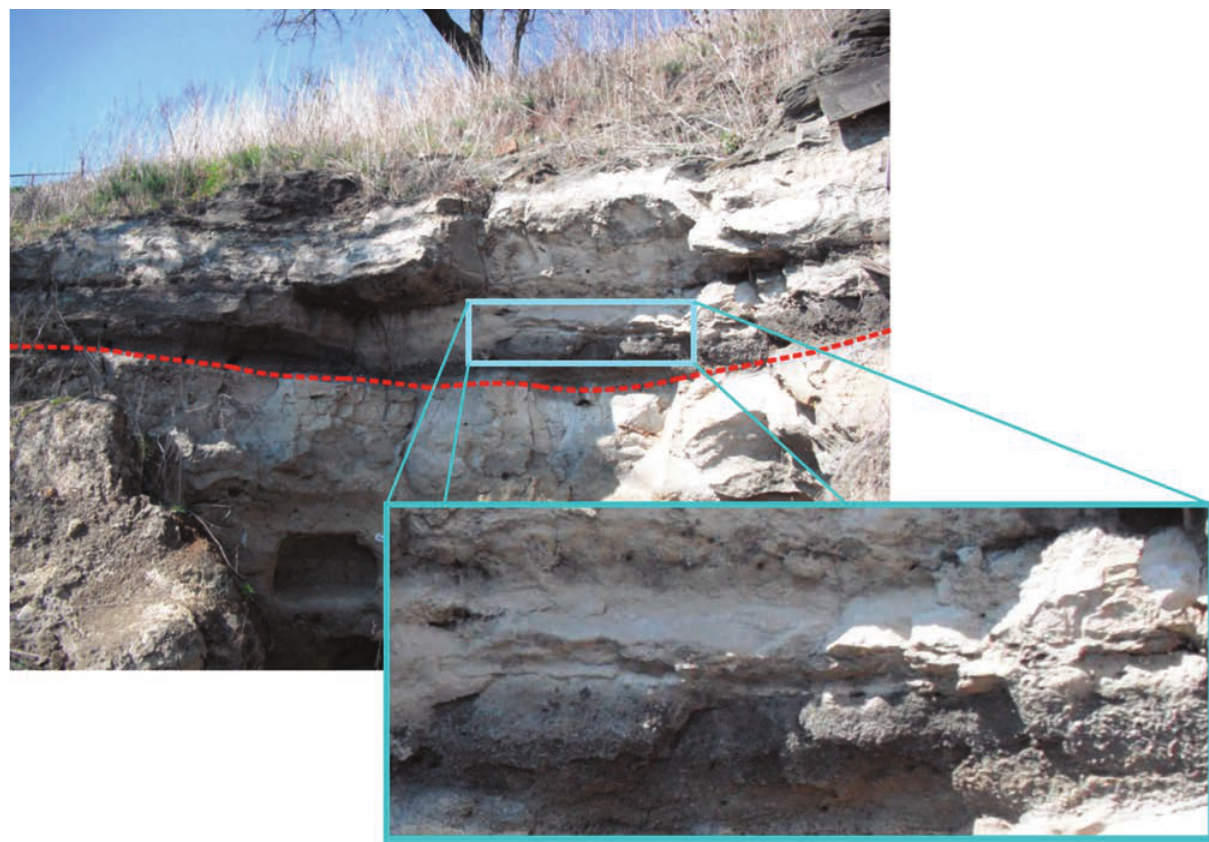
Figure 8. Sorano unit 2 ( lower unit) and Grotte di Castro Formation (upper unit)